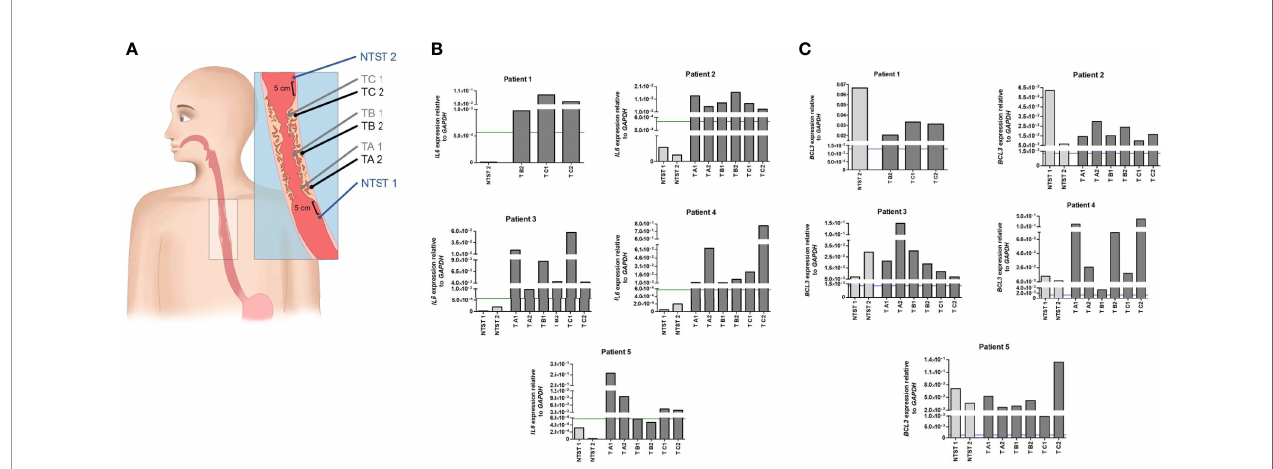
FIGURE 3 | Intratumor heterogeneity of IL6 and BCL3 expression in ESCC. (A) Schematic representation of sample collection by endoscopy for the evaluation of intratumor heterogeneity. From each patient, a total of eight biopsies was collected when possible. Non-tumor surrounding tissue samples were collected 5 cm below (NTST 1) and above (NIST 2) the tumor border. ESCC samples were collected from each third of the tumor mass (lower third, TA; middle third, TB; and upper third, TC), being one super fi cial (1) and another profound (2), the latter collected by a biopsy-on-biopsy scheme. (B) Bar graphs representing IL6 expression normalized with GAPDH in the different non-tumor surrounding tissue (NTST) and tumor biopsies from fi ve patients diagnosed with ESCC (Patient 1-5). The green line represents the IL6 expression cut-off that showed the highest accuracy to differentiate the tumor tissue from the non-tumor surrounding tissue, as shown in Figure 1B (5.7x10 -4 ). (C) Bar graphs representing BCL3 expression normalized with GAPDH in the different non-tumor surrounding tissue (NTST) and tumor biopsies from fi ve patients diagnosed with ESCC (Patient 1-5). The blue line represents the BCL3 expression cut-off that showed the highest accuracy to differentiate the non-tumor surrounding tissue from the esophageal mucosa from individuals without esophageal disorders, as shown in Figure 2C (1.3x10 -3